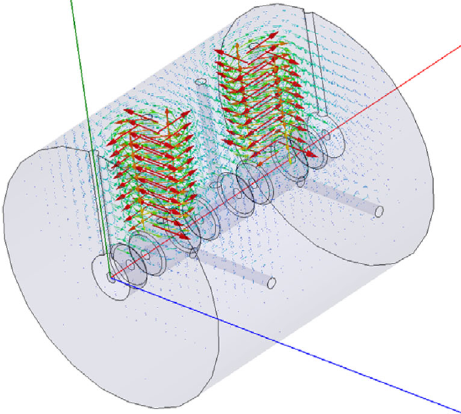
FIG. 11. A 3D view of stem mode magnetic field, showing weak coupling between stems and PCs: stem field lines do not intersect PCs.